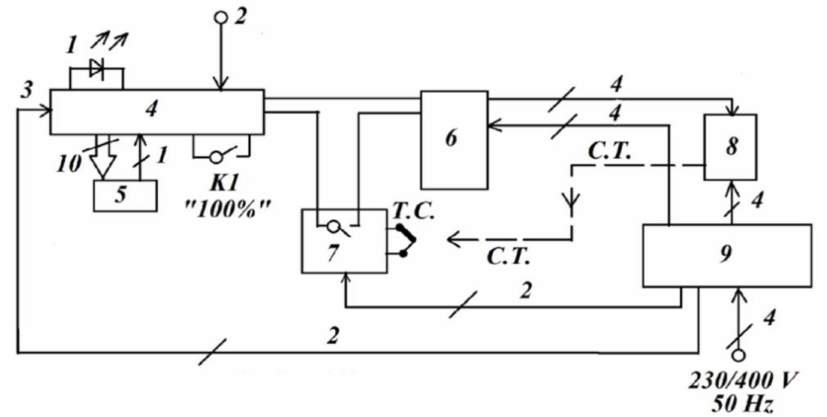
Figure 5. Block diagram of the thermal control system. (1) LED indicator; (2) +12 V power supply; (3) synchronization input; (4) digital control circuit; (5) selector switch; (6) solid state Zero Point Switch, SSR-4028ZD3, 40 A; (7) temperature controller; (8) heating element; (9) active energy meter; T.C.—thermocouple; C.T.—thermal contact through heated